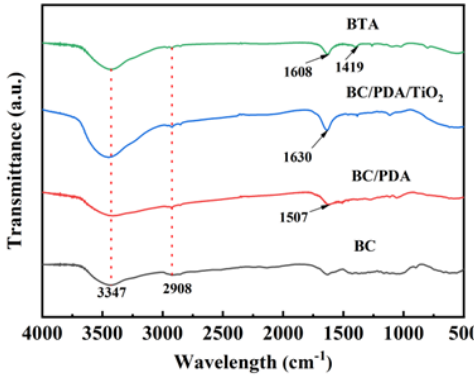
Figure 2. ( a ) TEM images of BTA and ( b ) BTA after magnification.